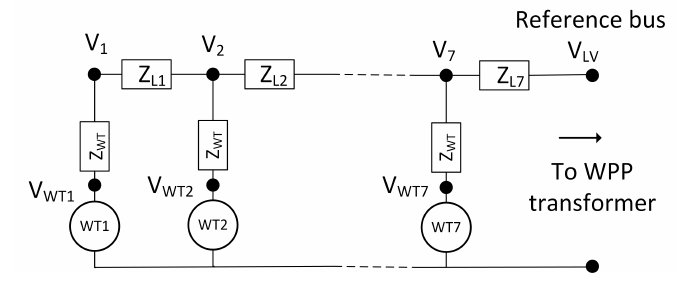
Figure 8. WPP layout with seven WTs on a feeder.